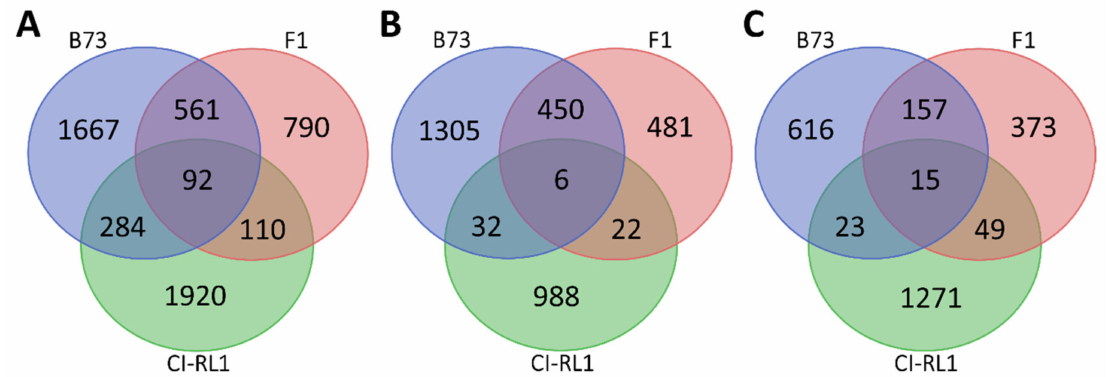
Figure 3. Venn diagrams of differentially expressed genes (DEGs), showing B73 susceptible (blue), F1 progeny (red), and CI-RL1 tolerant lines (green). ( A ) All DEGs ( p -values ≤ 0.01); ( B ) upregulated and ( C ) downregulated